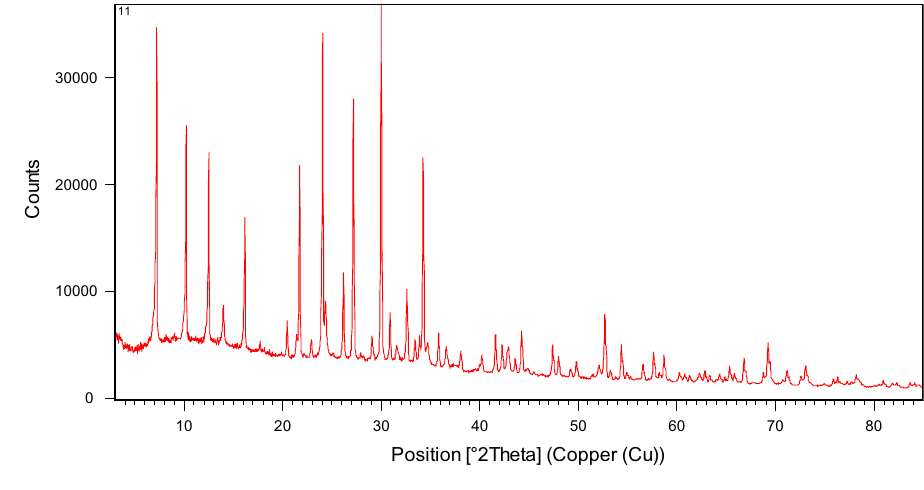
Fig. 1 XRD spectrum resulting from the utilized zeolite sample